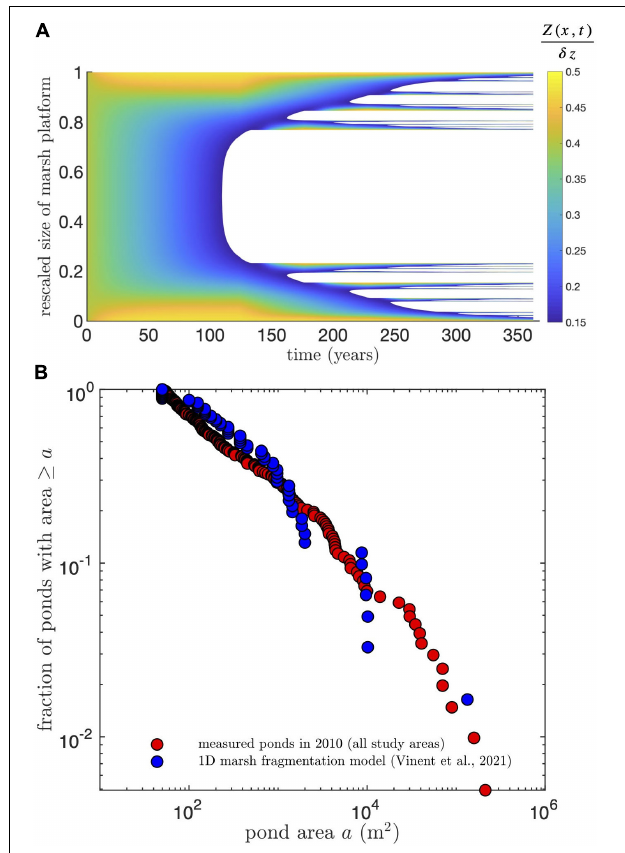
FIGURE 7 | Predictions from a simplified one-dimensional marsh drowning model (Vinent et al., 2021) applied to the conditions in our study areas. (A) Spatiotemporal diagram of predicted marsh fragmentation starting with a uniform marsh platform with tidal channels or mud flats at both sides. Marsh elevation Z is rescaled by tidal range dz. White areas indicate open water. (B) Comparison of simulated and measured exceedance probability of pond areas. Since the model is 1D, the simulated pond area is calculated by multiplying the simulated pond length by a constant pond width obtained from the condition that the smallest simulated pond has an area of 50 m 2 (the smallest area resolved in the measurements). Measured ponds correspond to ponds in all study areas in